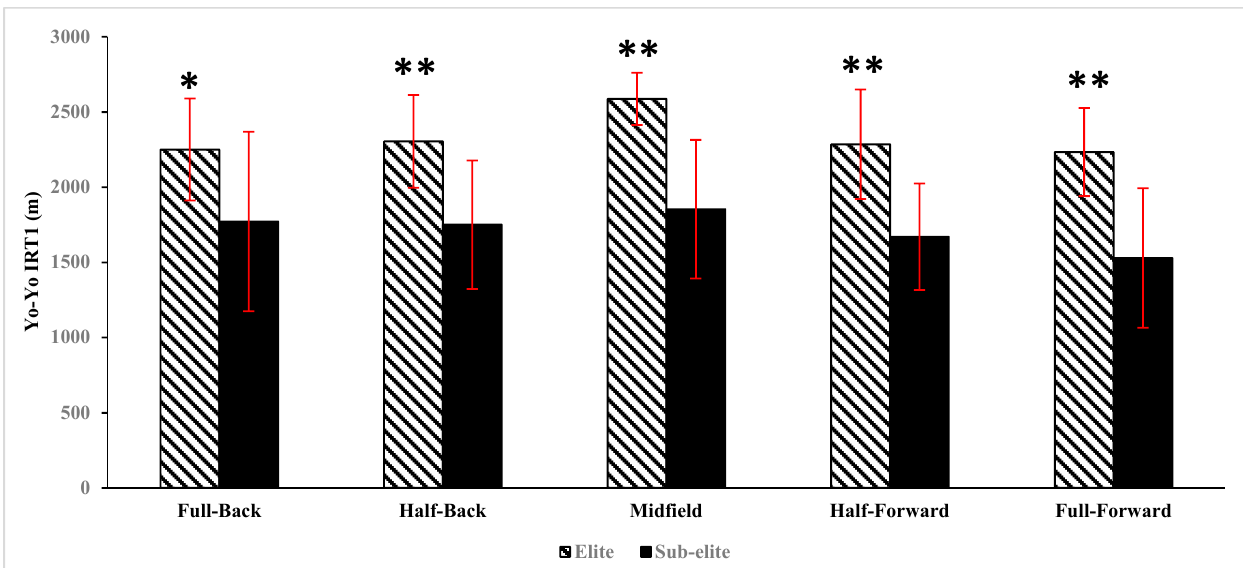
Figure 1. Yo-yo intermittent recovery test level 1 (Yo-Yo IRT1) distance (m) across hurlers with respect to position and level of play. Data presented as mean ± standard deviation (SD). Significantly greater than sub-elite at respective positions = * ( p < 0.05), ** ( p < 0.001) .